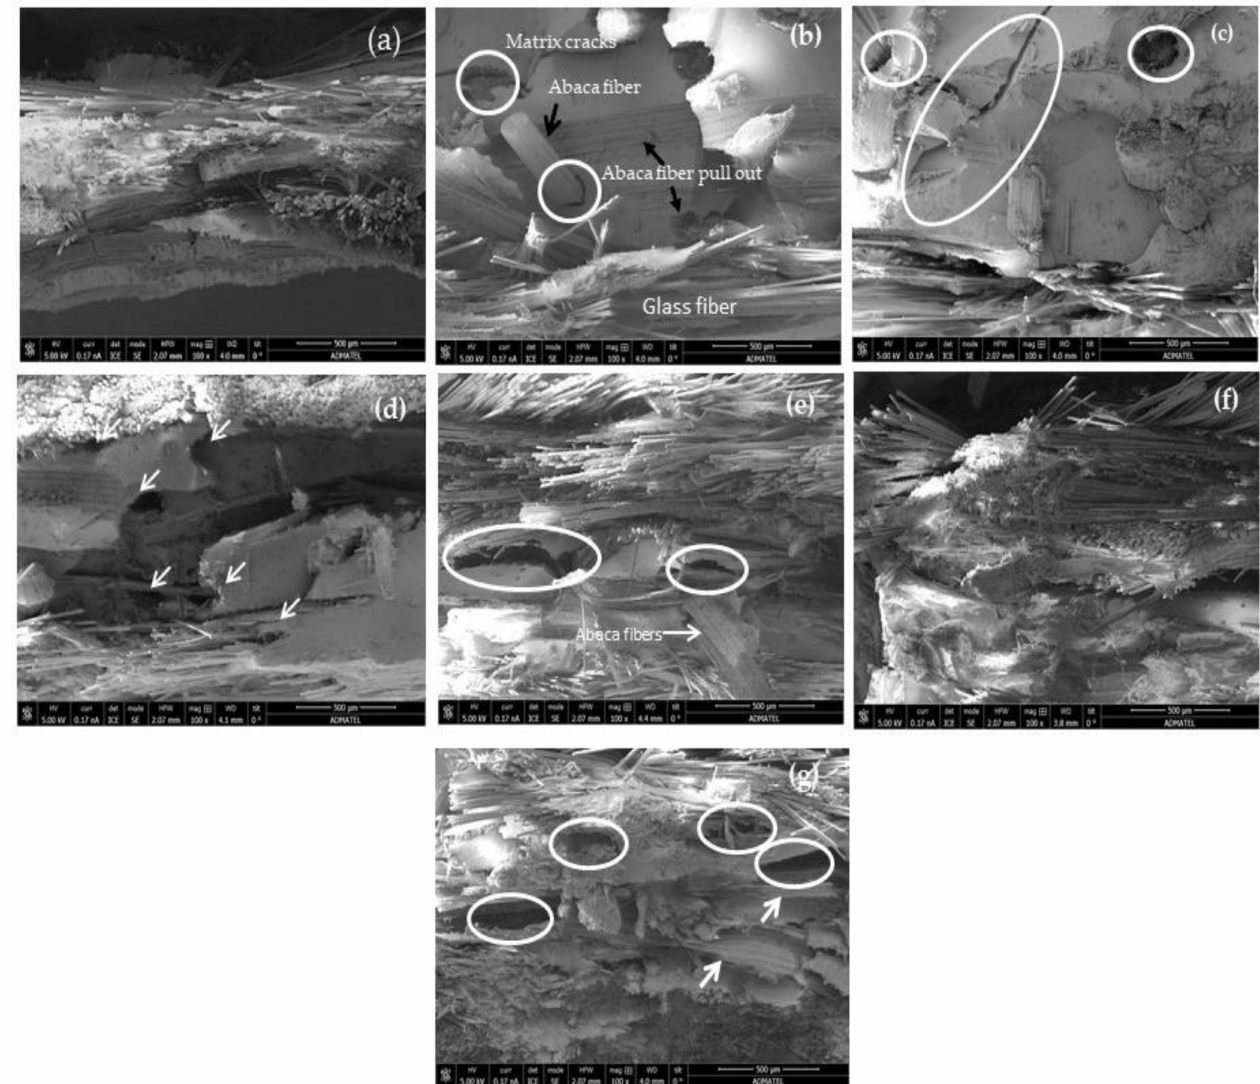
Figure 6. SEM images of tensile fractures of ( a ) laminate 1, ( b ) laminate 3, ( c ) laminate 4, ( d ) laminate 5, ( e ) laminate 6, ( f ) laminate 8, and ( g ) laminate 9. Note: Arrow indicates poor interaction between fibers and matrix, voids and matrix